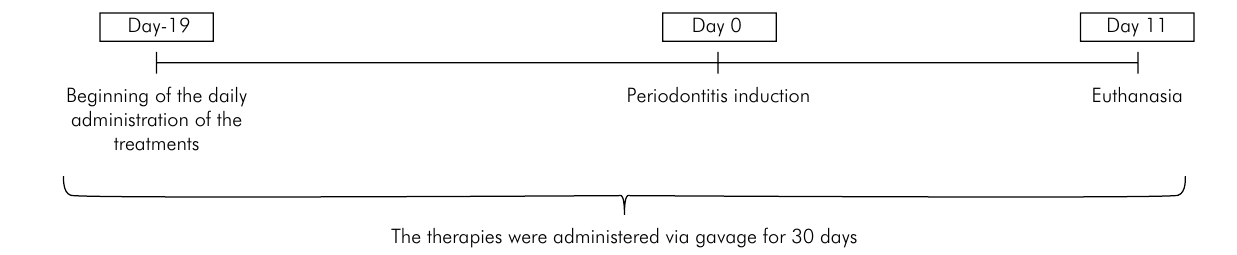
Figure. Schematic illustration of the study